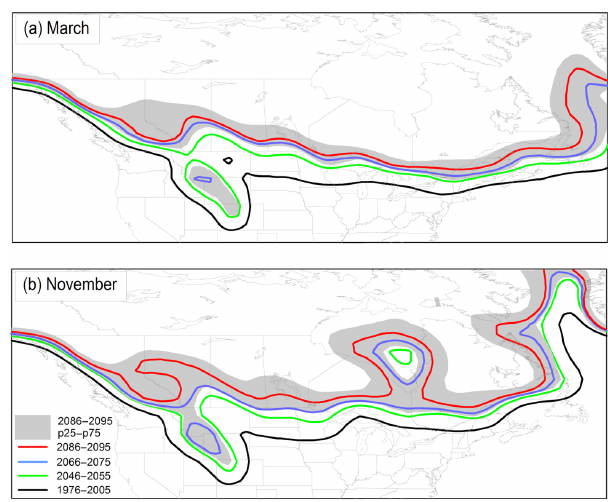
Figure 8. Locations of the 0 ◦ C isotherm during (a) March and (b) November over four different time periods. The NCEP/NCAR re-analysis was used to compute locations for 1976–2005. The fu- ture time periods were computed by adding the CMIP5 39-model ensemble median of the RCP8.5 10-year mean air temperature delta (future period – 1976–2005 historical) projected for three different periods to the NCEP/NCAR climatology. The grey area shows the region bounded by the 0 ◦ C isotherms in the 25th and 75th ensemble percentiles of the 2086–2095 mean air